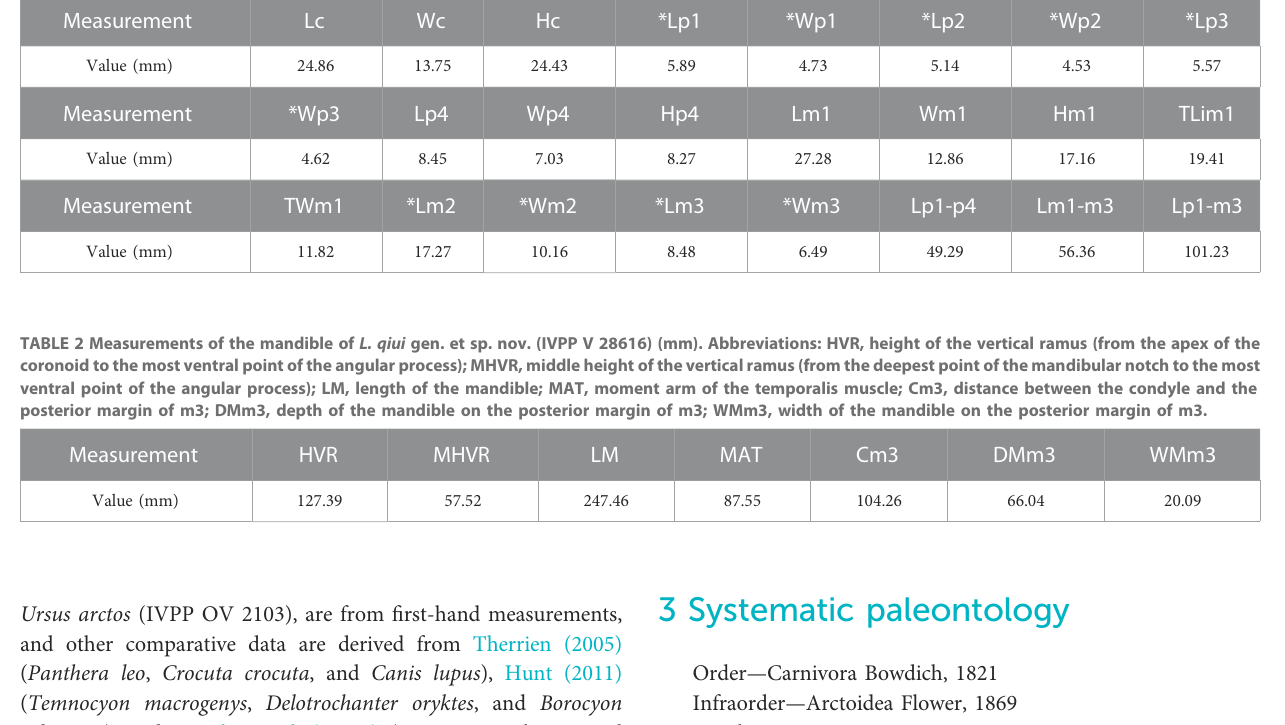
TABLE 1 Measurements of the lower teeth of L.qiui gen. et sp. nov. (IVPP V 28616) (mm). Abbreviations: L, length; W, width; H, height; TLi, trigonid lingual length; TW, talonid width; *, measured from alveoli or root. Measurement